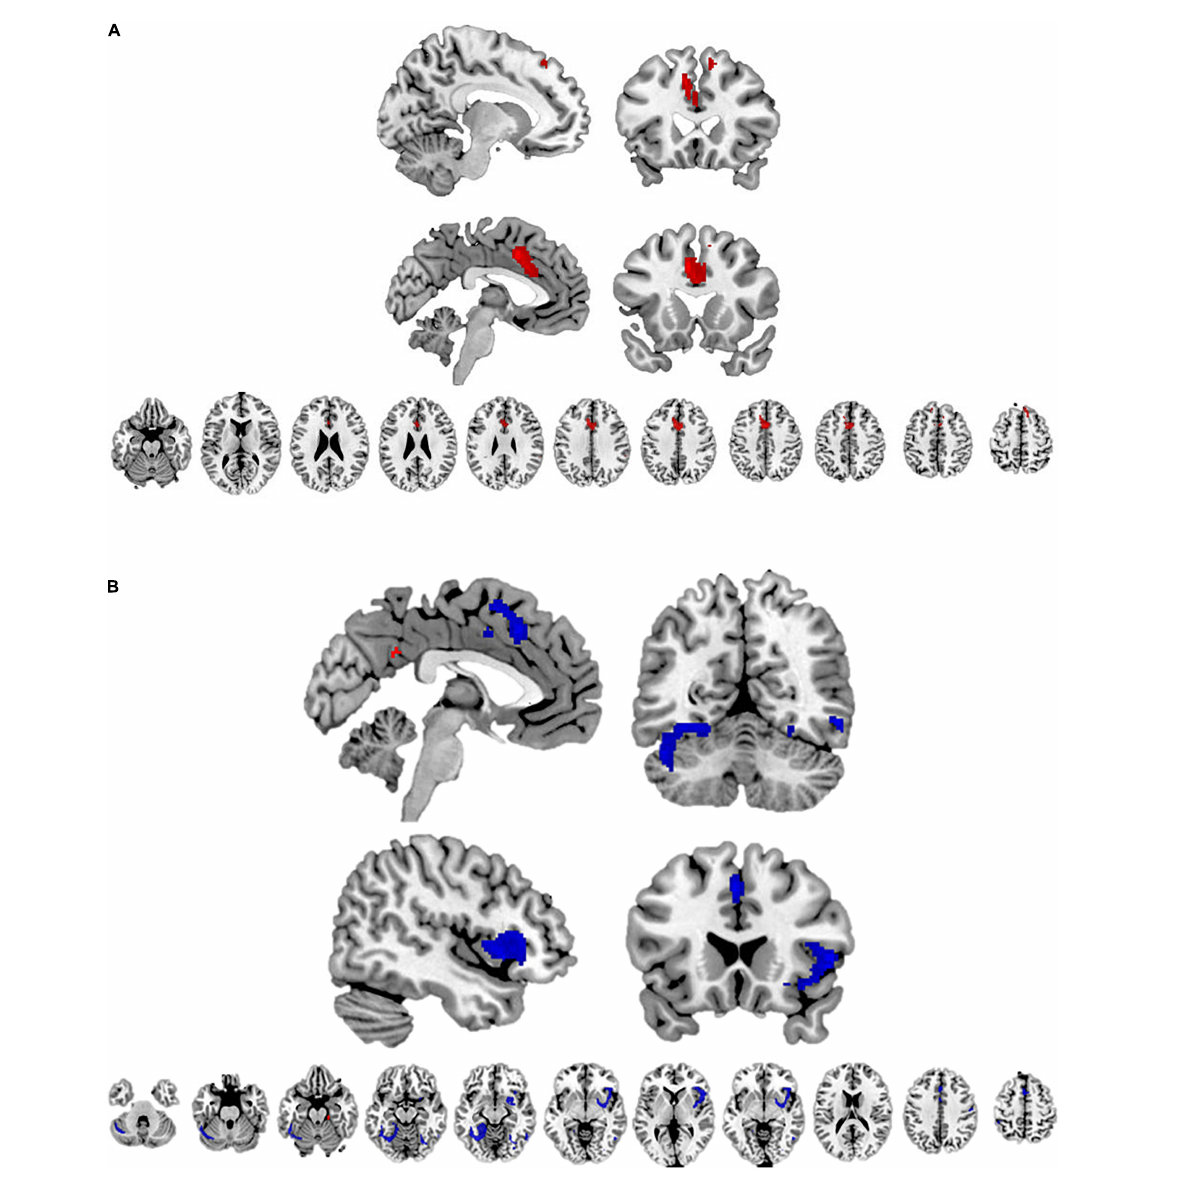
FIGURE3 (A) The brain regions with lower activity toward White (vs. non-White) target individuals (marked with red color). (B) The brain regions with lower activity toward Black (vs. non-Black) target individuals are marked with red color; and the brain regions with higher activity toward Black (vs. non-Black) target individuals are marked with blue